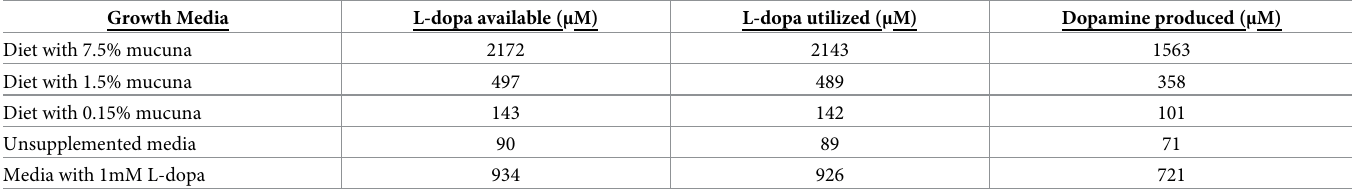
Table 1. Dopamine production increases with increasing L-dopa